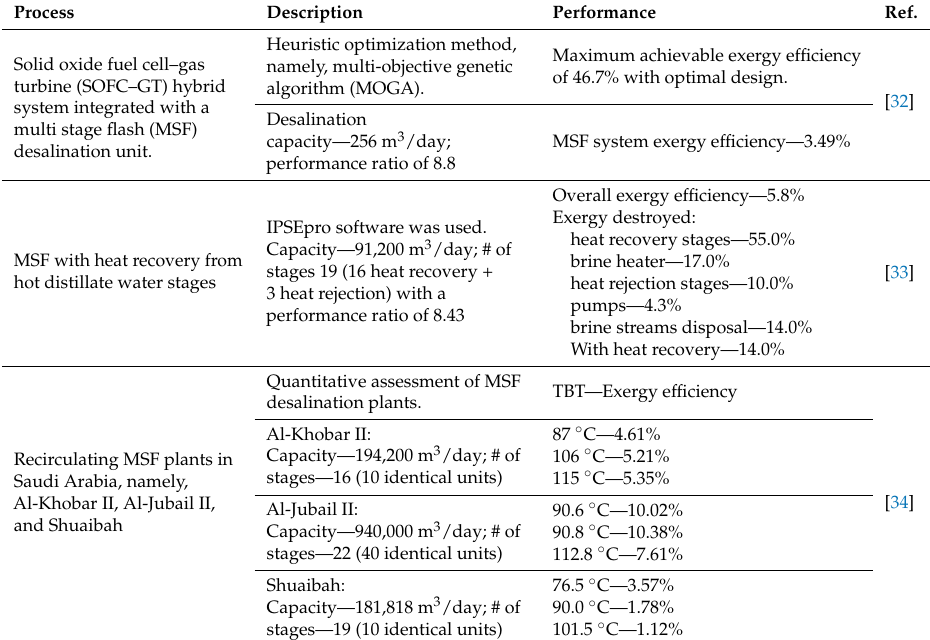
Table 3. Exergy performance in MSF